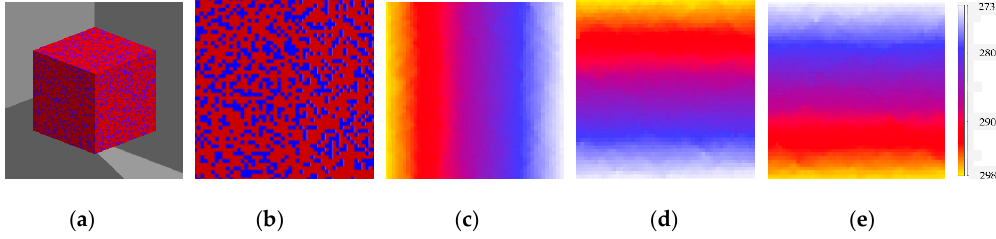
Table 1. The parameters of the extracted digital rock.